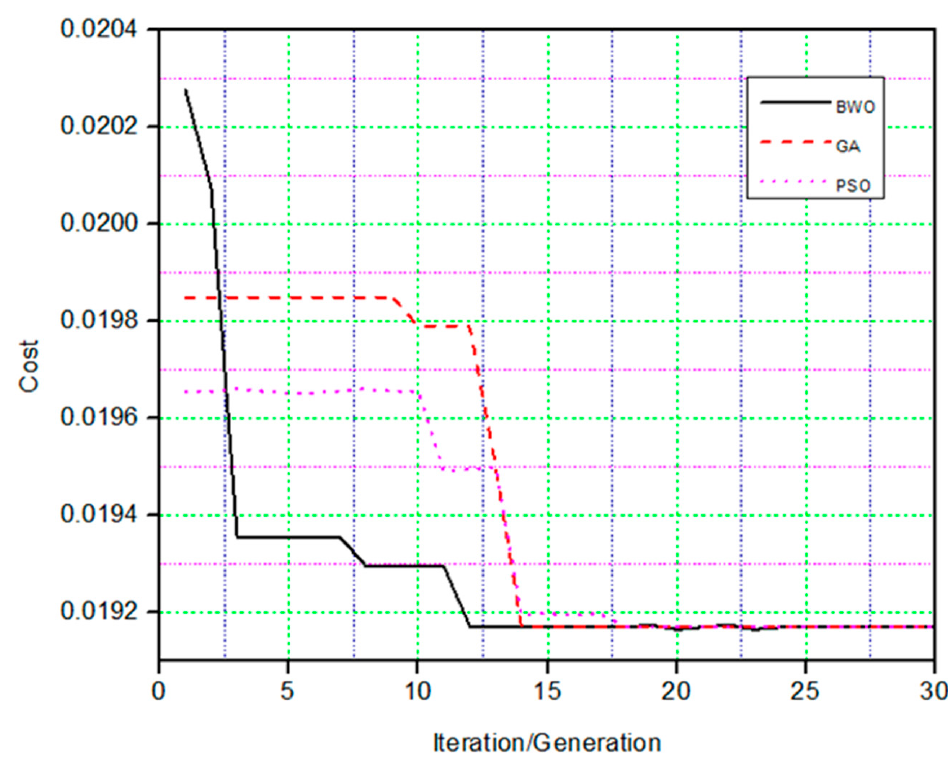
Figure 9. Cost convergence comparison of the BWO, PSO, and GA.